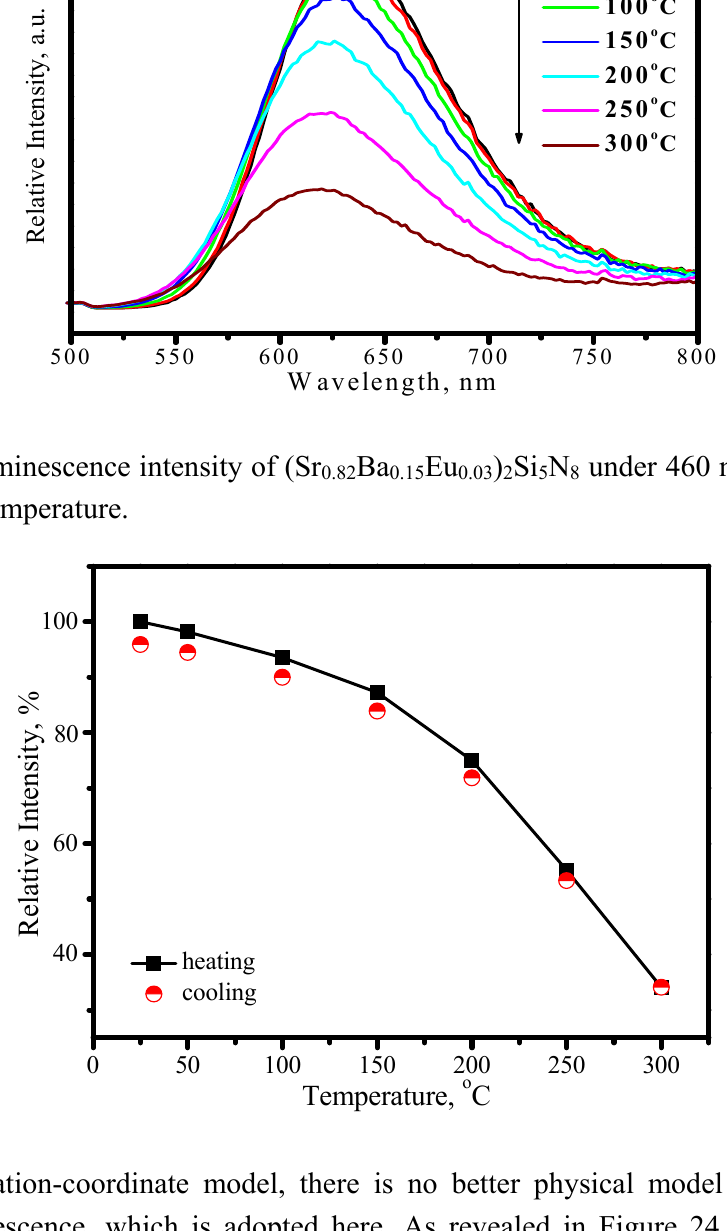
Figure 22. Emission spectra ( λ excitation measured at different temperature.